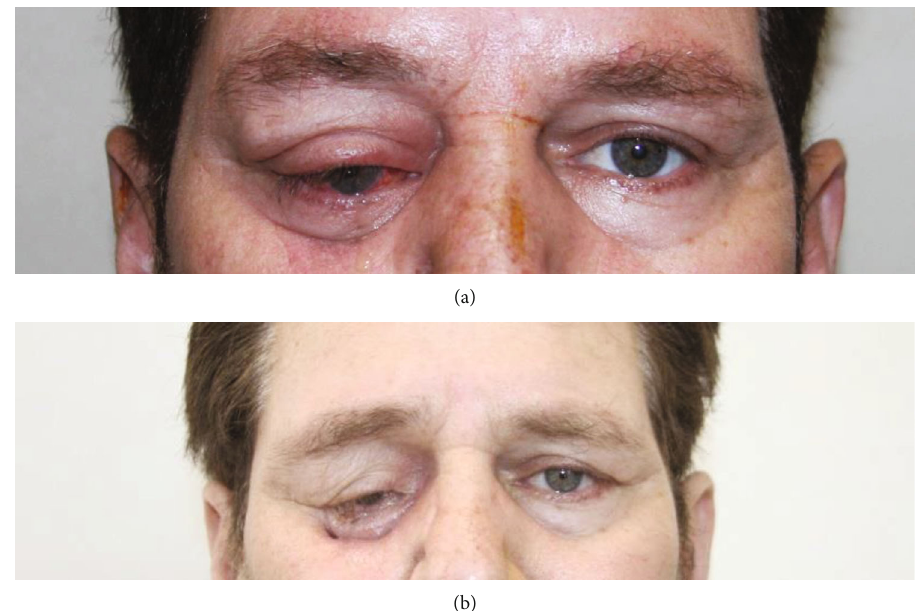
Figure 4: Preoperative (a) and postoperative (b) external pictures showing resolution of proptosis after